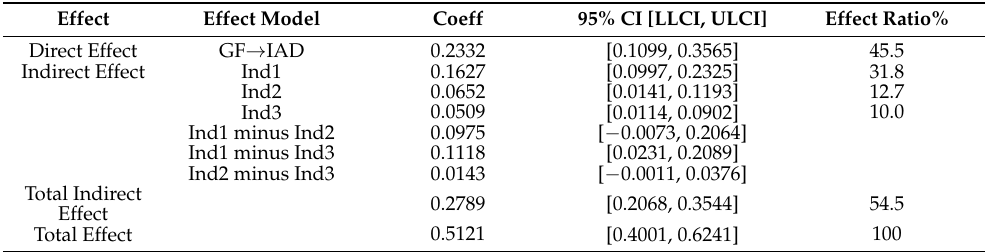
Table 4. The chain-mediated effects of family dysfunction on Internet addiction and bias-corrected 95% confidence